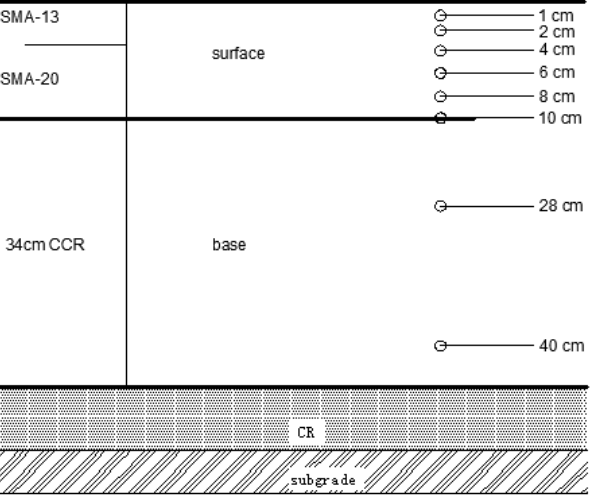
Coatings 2019 , 9 , x FOR PEER REVIEW Figure 3. Pavement structure and sensor embedding diagram. Figure 3. Pavement structure and sensor embedding diagram.